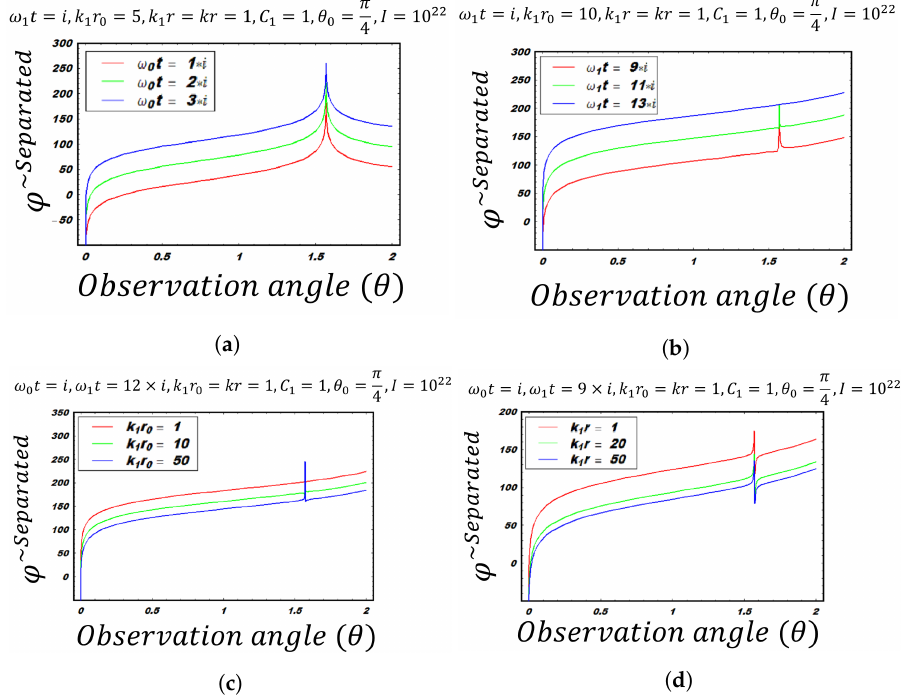
Figure 2. Variation of diffracted potential with observation angle for various values of ( a ) fluctuating strip frequency ( b ) incident wave frequency ( c ) distance from the fluctuating source to the fluctuating strip ( d ) distance from the observer to the fluctuating strip.